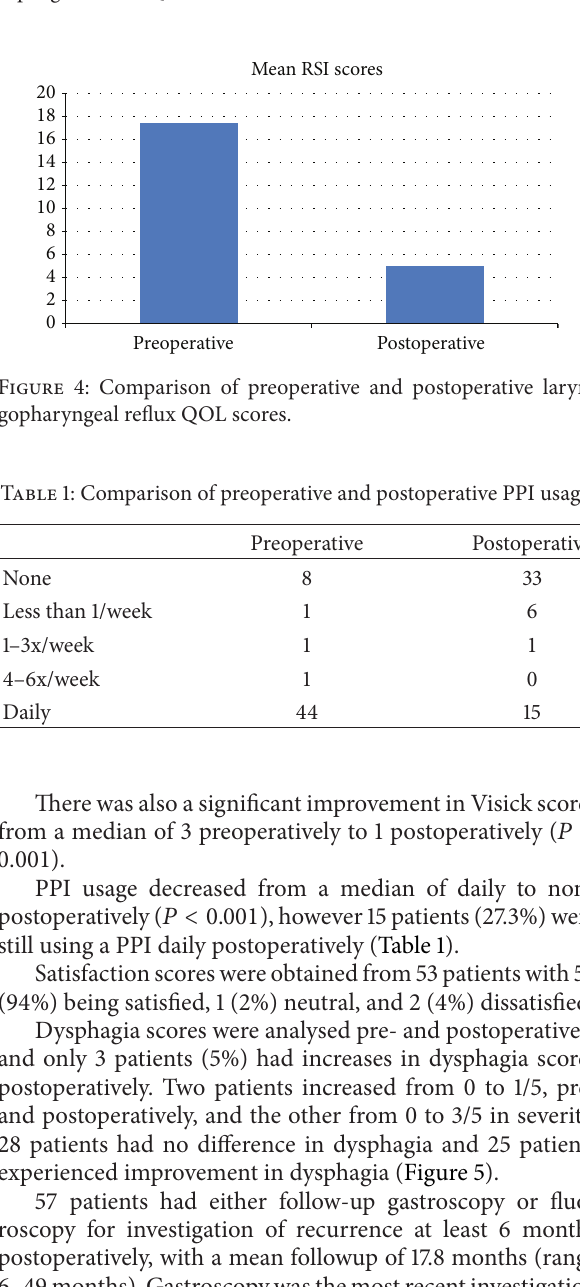
Figure 3: Comparison of preoperative and postoperative gastrooe- sophageal reflux QOL scores.